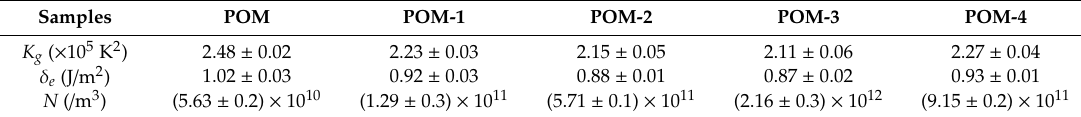
Table 5. Lauritzen-Ho ff man model parameters of POM / Ag